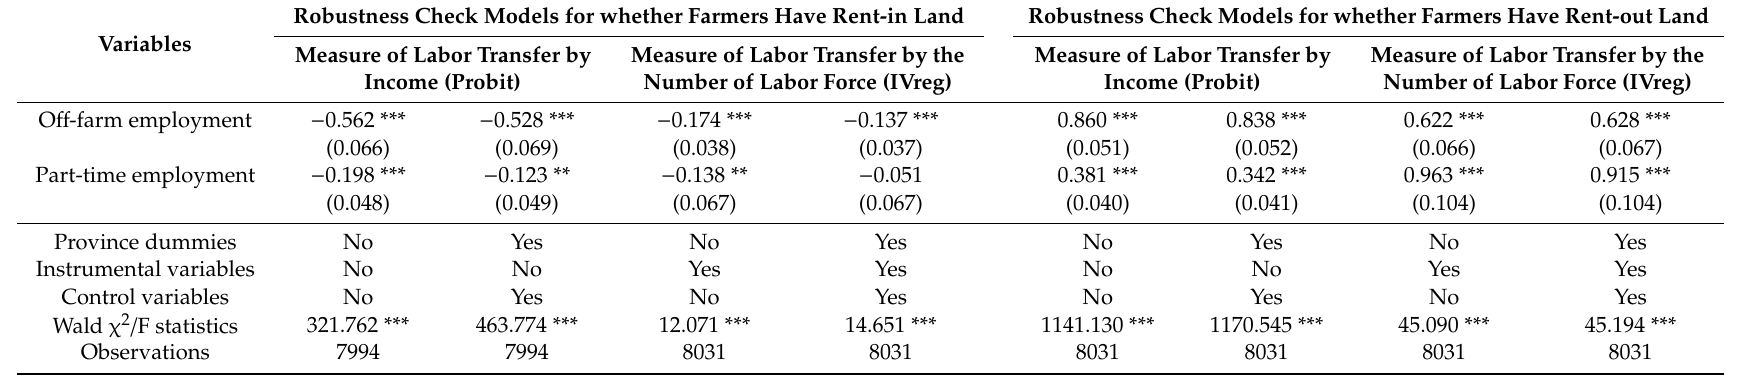
Table 4. Robustness check models estimation results of land transfer direction of farmers.